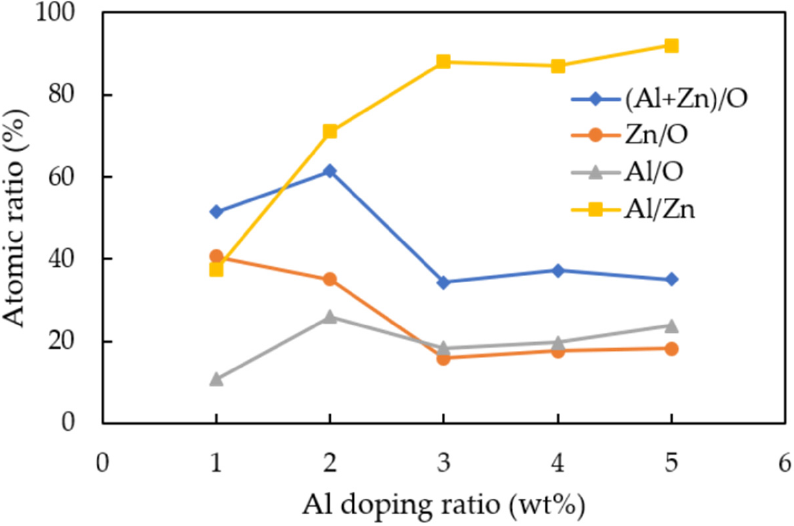
Figure 4. Variations of Al/Zn, Al/O, Zn/O, and (Al+Zn)/O atomic ratios calculated from EDX analysis of AZO films deposited with different Al ratios by the mist CVD method.